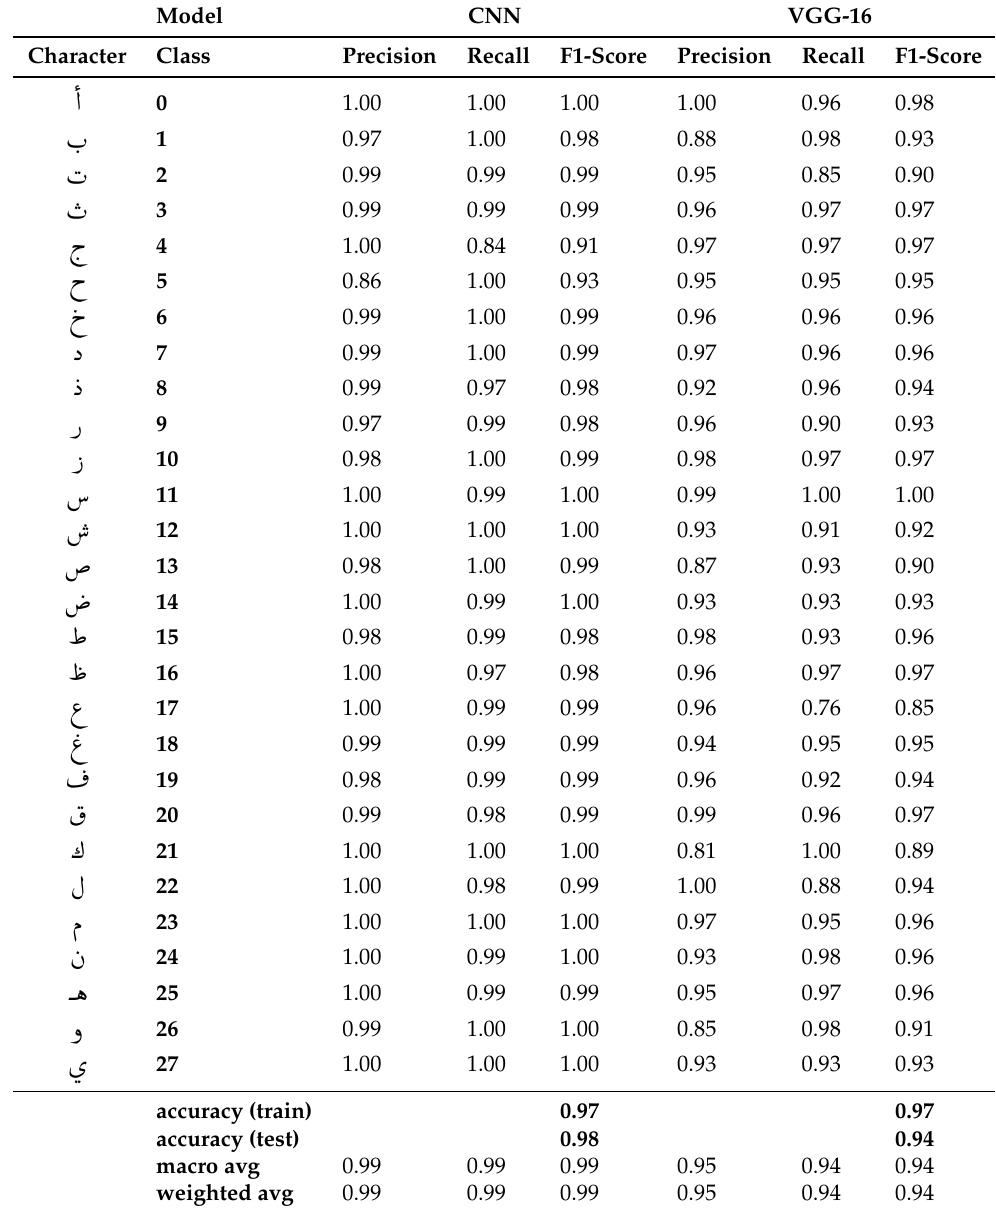
Table 5. The results and comparison of the CNN and VGG16 models on the AHCD dataset. Model